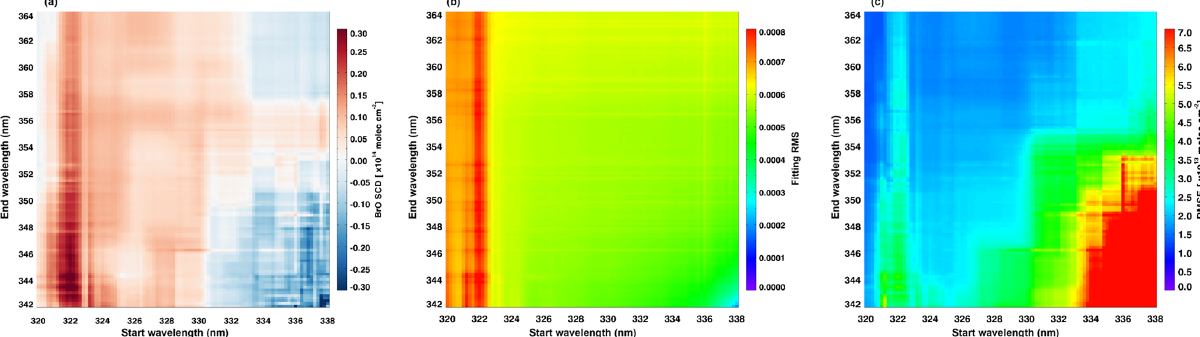
Figure 7. Mean values of (a) BrO SCDs, (b) fitting rms values, and (c) root-mean-square deviation of BrO SCDs retrieved over the clear part of the scene in the Pacific background region using TROPOMI measurements at different wavelength